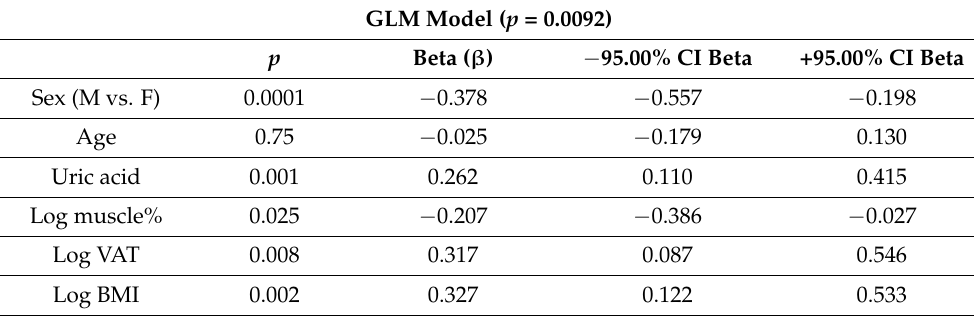
Table 3. General Linear Model (GLM) analysis of independent determinants of log-transformed leptin levels in terms of body composition and biochemical data; n =